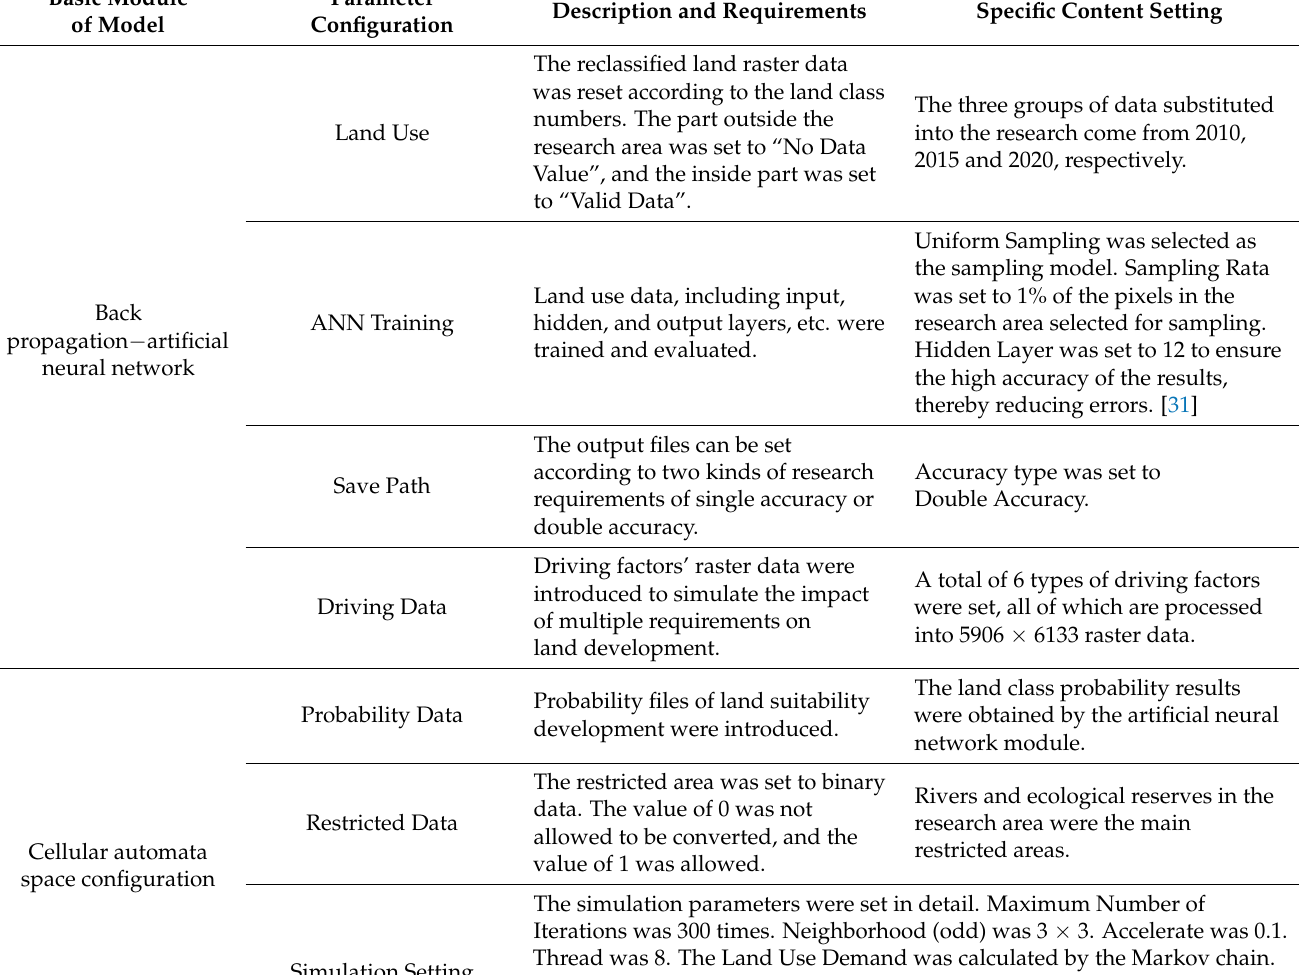
Table 1. Parameter settings of the FLUS−Markov coupling model.